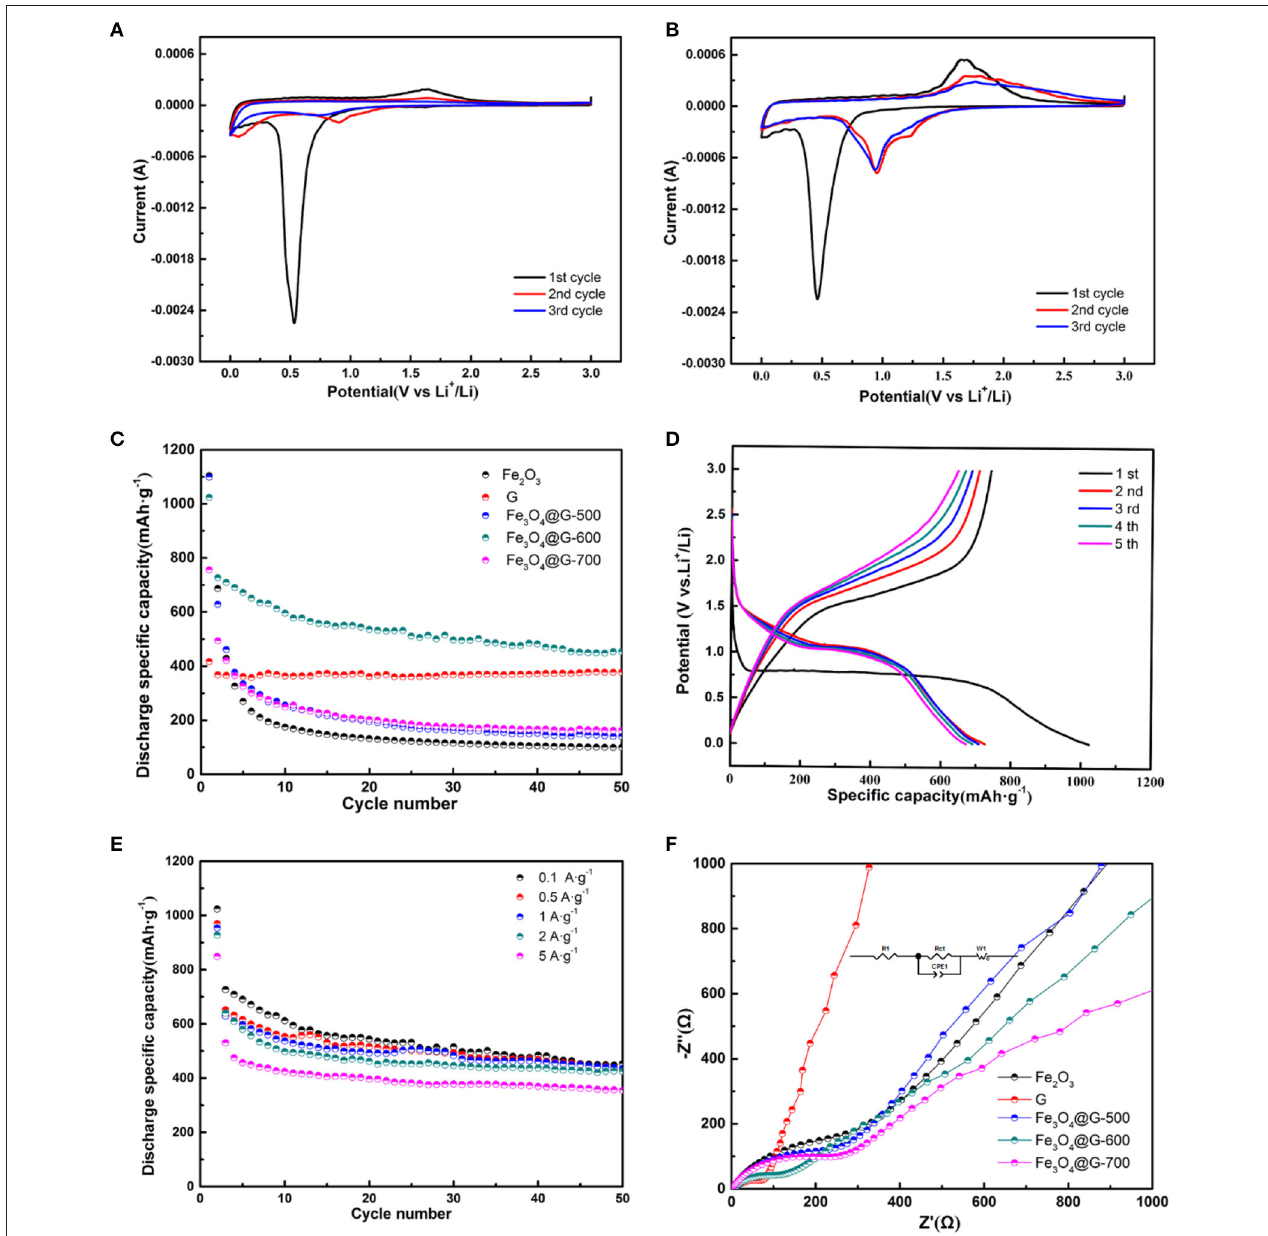
FIGURE 3 | CV curves of (A) Fe 2 O 3 and (B) Fe 3 O 4 @G-600 electrodes from the first cycle to the third cycle at a scan rate of 0.1 mV · s − 1 in the potential range of 0.01 and 3.0V (vs. Li + /Li). (C) Cycle performances at 0.1 A · g − 1 of the Fe 2 O 3 , G, Fe 3 O 4 @G-500, Fe 3 O 4 @G-600, and Fe 3 O 4 @G-700 electrodes. (D) The first to fifth galvanostatic charge-discharge profiles and (E) rate capabilities of Fe 3 O 4 @G-600 electrode. (F) Nyquist plots of the Fe 2 O 3 , G, Fe 3 O 4 @G-500, Fe 3 O 4 @G-600, and